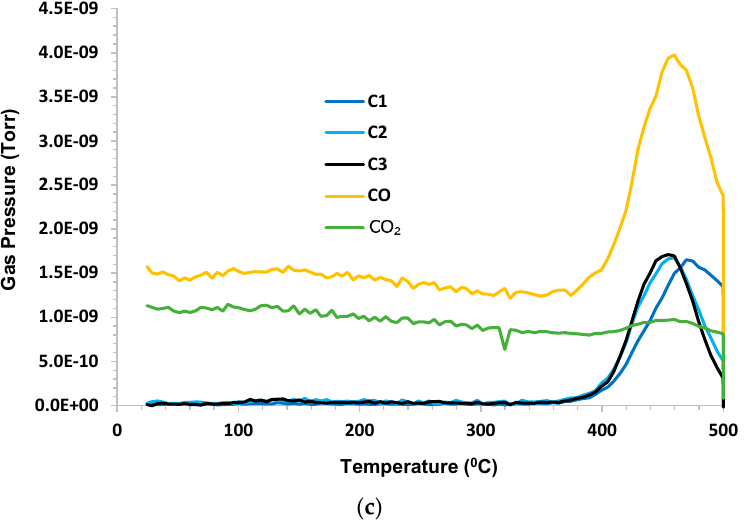
Figure 2. Grassy Creek in argon. ( a ) Gas pressure and temperature as a function of time. ( b ) H 2 evolved (vol%) as a function of time. ( c ) Gas pressure as a function of temperature.